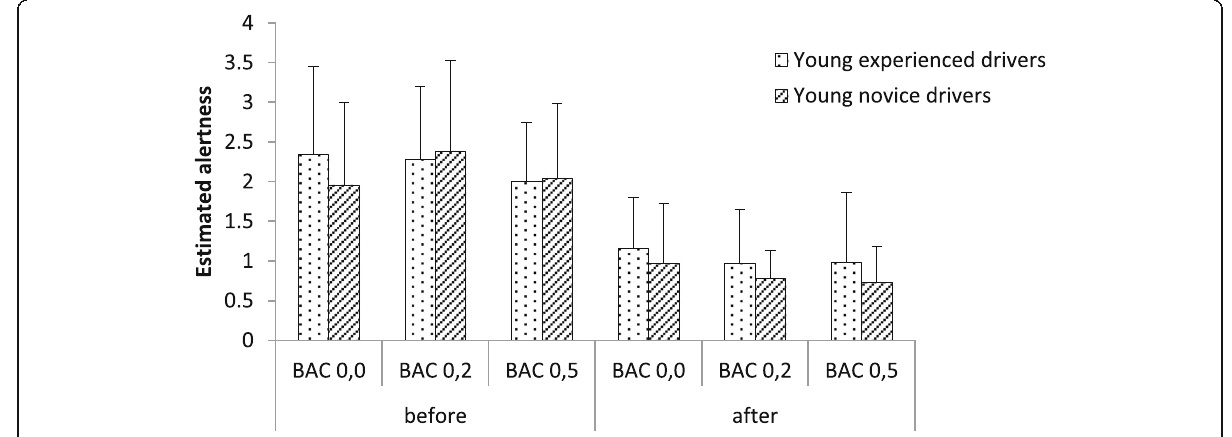
Fig. 2 Mean self-reported alertness level before and after driving session for each group and each